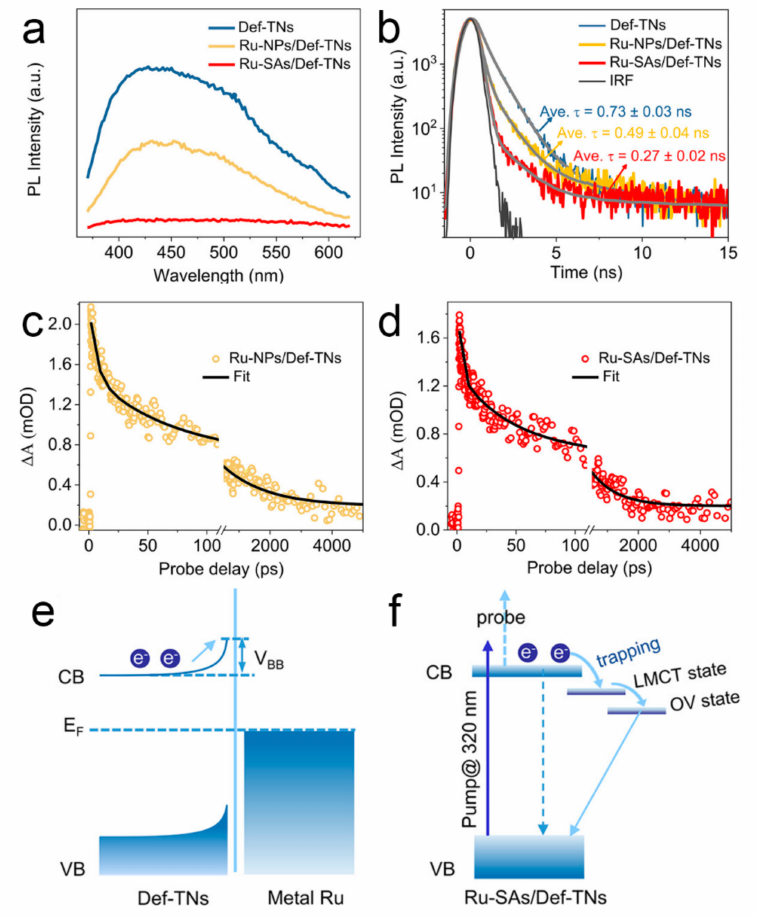
Figure 4. ( a ) PL emission spectra and ( b ) time-resolved PL kinetics (excitation at 320 nm, emission at 420 nm) for Def-TNs, Ru-NPs/Def-TNs, and Ru-SAs/Def-TNs. The solid gray lines are the triexponential fits after deconvolution with the instrument response function (black). ( c ) Ru-NPs/Def- TNs and ( d ) Ru-SAs/Def-TNs (probing at 630 nm). Mechanisms underlying the photoexcited electron dynamics involved in ( e ) Ru-NPs/Def-TNs and ( f ) Ru-SAs/Def-TNs, where VB, CB, E F , V BB , LMCT, and OV denote the valence band, conduction band, Fermi level, Schottky barrier, ligand-to-metal charge transfer, and oxygen vacancy, respectively. Adapted with permission from Ref.